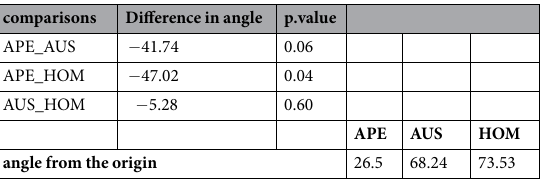
Table 1. Multivariate angle of evolutionary rates. The row names correspond to individual comparisons of one group to another. APE = great apes exclusive of hominins, AUS = australopiths, HOM = Homo species. Calculations were performed on the whole numbers, while the table only reports approximated round- down values to